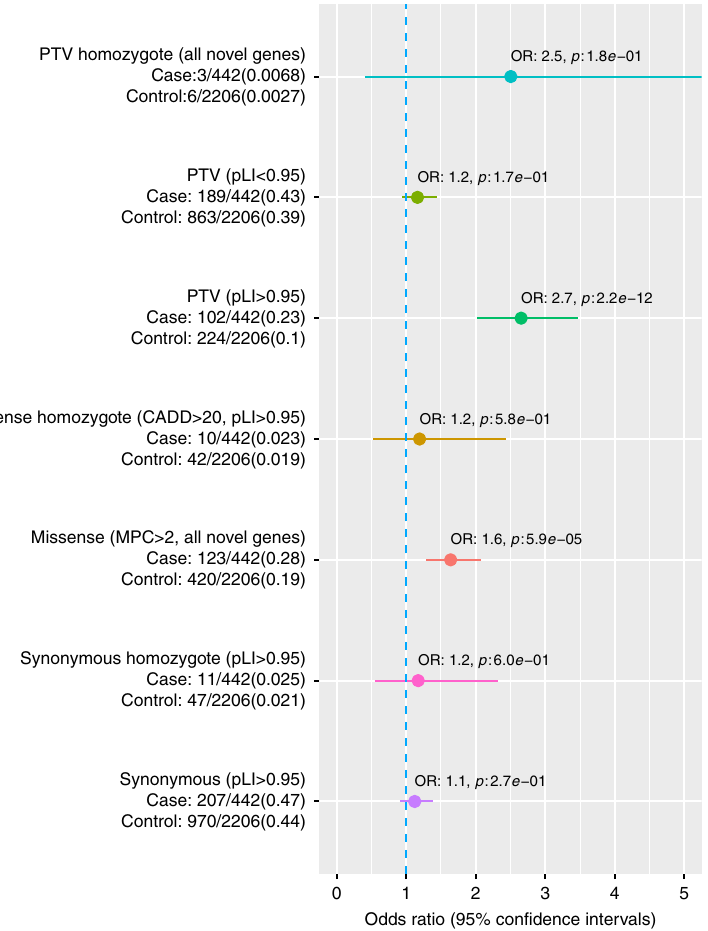
Fig. 3 Enrichment of rare variants in genes not previously associated with NDDs. Variants not observed in GnomAD or Finnish controls in novel ID genes in cases compared to genetically matched controls (see Methods). Rate in each variant category is fi rst estimated for all novel genes and then after subsetting to only novel high pLI genes. All missense variants are predicted to be deleterious (MPC > 2, see Methods). On the left the number of carriers and total individuals are given and in parenthesis the proportion of carriers. Circles indicate the odds ratio (OR) and lines indicate the 95% con fi dence interval of the OR. The synonymous variant identi fi cation comparison was performed to assess if possible differences in the variant identi fi cation rate due to batches/capture differences were adequately controlled. PTV protein truncating variant, CADD Combined Annotation-Dependent Depletion pathogenicity score, pLI probability of loss of function intolerance. Source data are provided as a Source Data fi